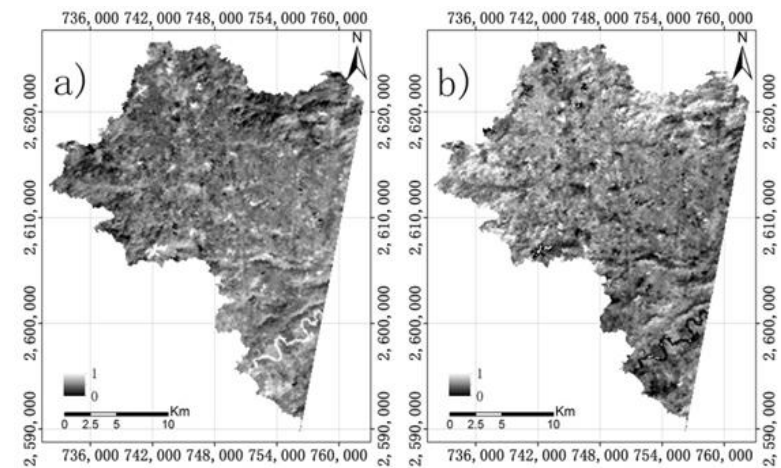
Figure 9. The area fractions of ( a ) soil and ( b ) vegetation derived from the HJ-1A HIS band 848 nm